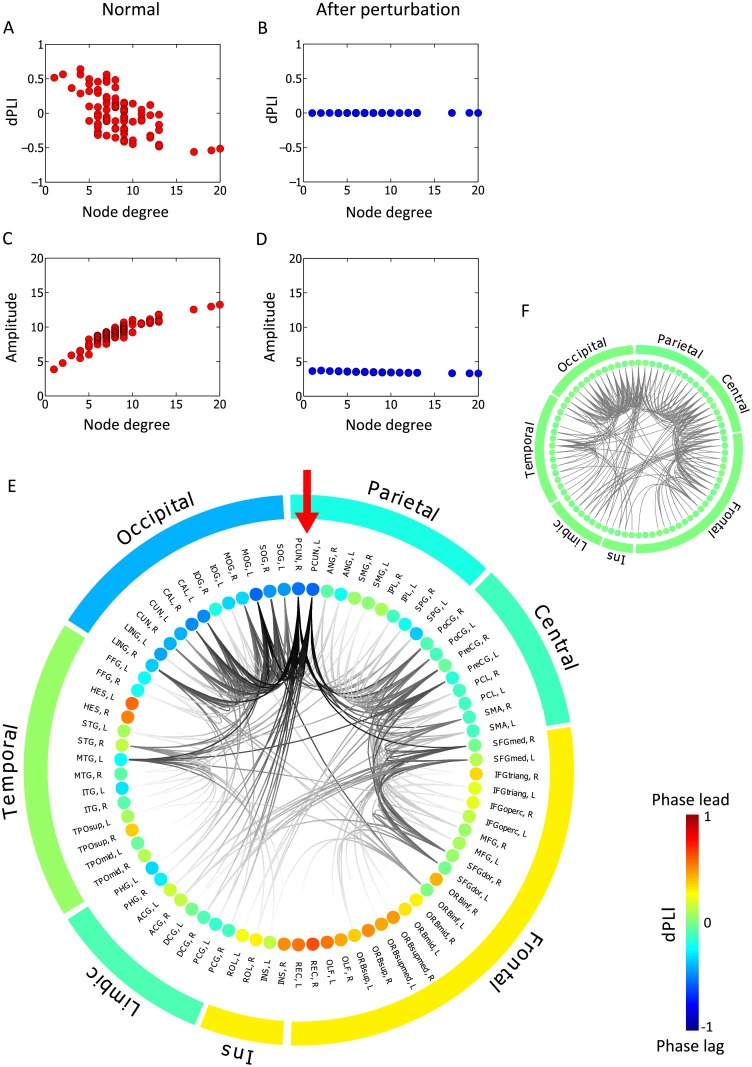
Relationships of node degree, amplitude and dPLI in human neuroanatomical networks.The Stuart-Landau model was simulated on the human anatomical brain network before ((A), (C) and (E)) and after ((B), (D) and (F)) perturbation with preferential disruption of hub nodes. The general relationship of node degree, amplitude and dPLI is also demonstrated in this modeled human brain network. The strong negative correlations between node degree and dPLI in (A) and the strong positive correlation between node degree and amplitude in (C) disappear in the perturbed homogeneous network ((B) and (D)). Average dPLI for each node was calculated by averaging the dPLI values of each node with respect to all other nodes. The anatomical connectivity of different brain regions are presented in (E) and (F) ring plots together with average dPLI value for each region. The nodes are aligned in groups: frontal lobe, central regions (including motor and somatosensory cortex), parietal lobe, occipital lobe, temporal lobe, limbic region, and Insula (Ins). Red arrow in (E) points to left and right precuneus. Color of each node shows the average dPLI values with respect to other nodes, from red (dPLI = 1) to blue (dPLI = -1). Average dPLI for each group is also shown in color. The inset within the ringplot shows connections between nodes, highlighted by darker color if the node has a higher degree of connections. Only the links from hub nodes (node with degree value within top 30%) are colored. In the simulation, the time delay between each node was given proportional to the delay, with propagation speed of 6m/s. The coupling strength S was given as 3. The full names for the cortical regions of the human brain network are available in Gong et al. [47].